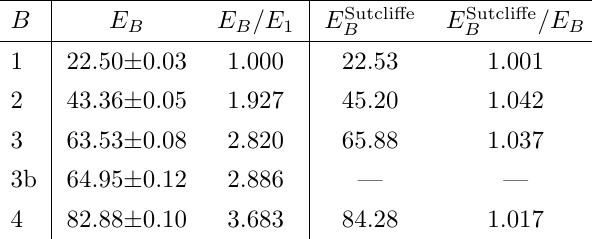
Table 1 . Comparison of the energies of the true solutions E B for baryon numbers B = 1 ; 2 ; 3 ;